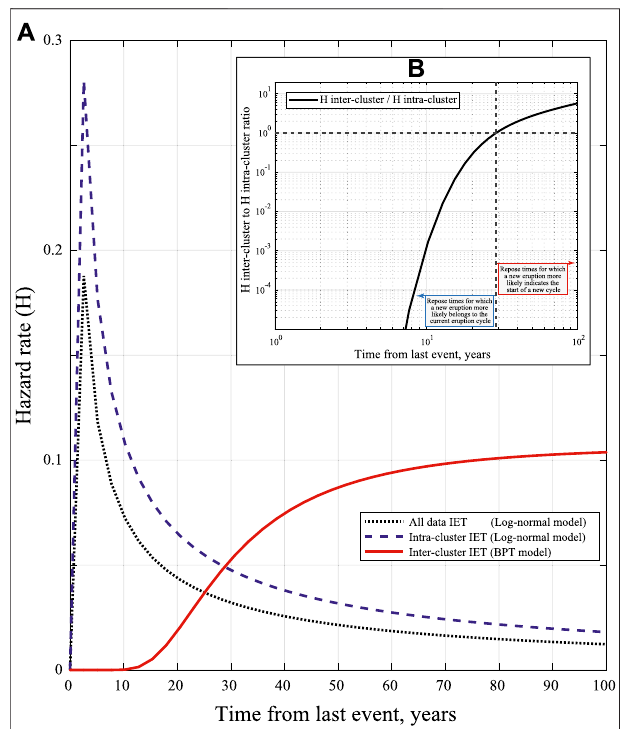
FIGURE 9 | Panel A : Hazard function ofthe BPTdistribution selected as the preferred model for describing the inter-cluster time intervals (i.e., time periods between the onset of eruptive cycles), the Lognormal model selected as the preferred model for describing the intra-cluster IETs (in both cases, considering the 6-clusters partition), and the Lognormal model describing all the IETs together without partition into cluster. Inset B : ratio of the inter-to the intra-cluster hazard function given in panel A, highlighting the complementary domains over which the two processes are more likely to explain repose